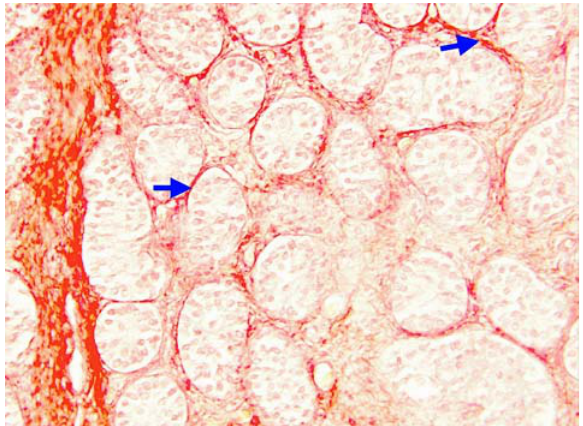
Figure 4 – Photomicrography of testicular parenchyma of a treated patient (picrosirius red,